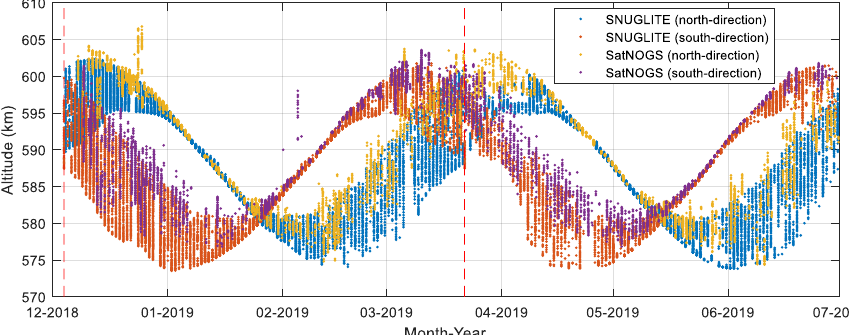
Figure 5. Altitude records calculated by on-board GPS receiver from launch date to late June 2019.